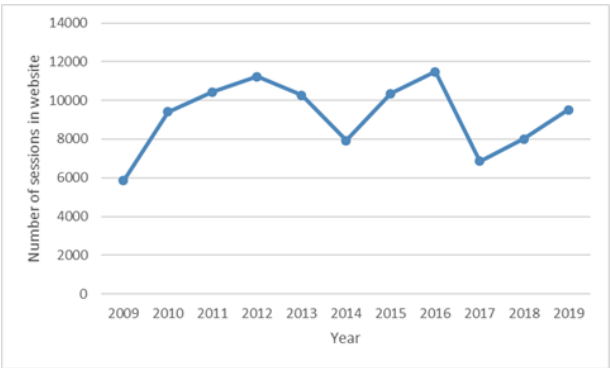
Figure 5. Number of consultations of the CIAT genebank website (https://ciat.cgiar.org/what-we-do/crop-conservation -and-use/) in the period